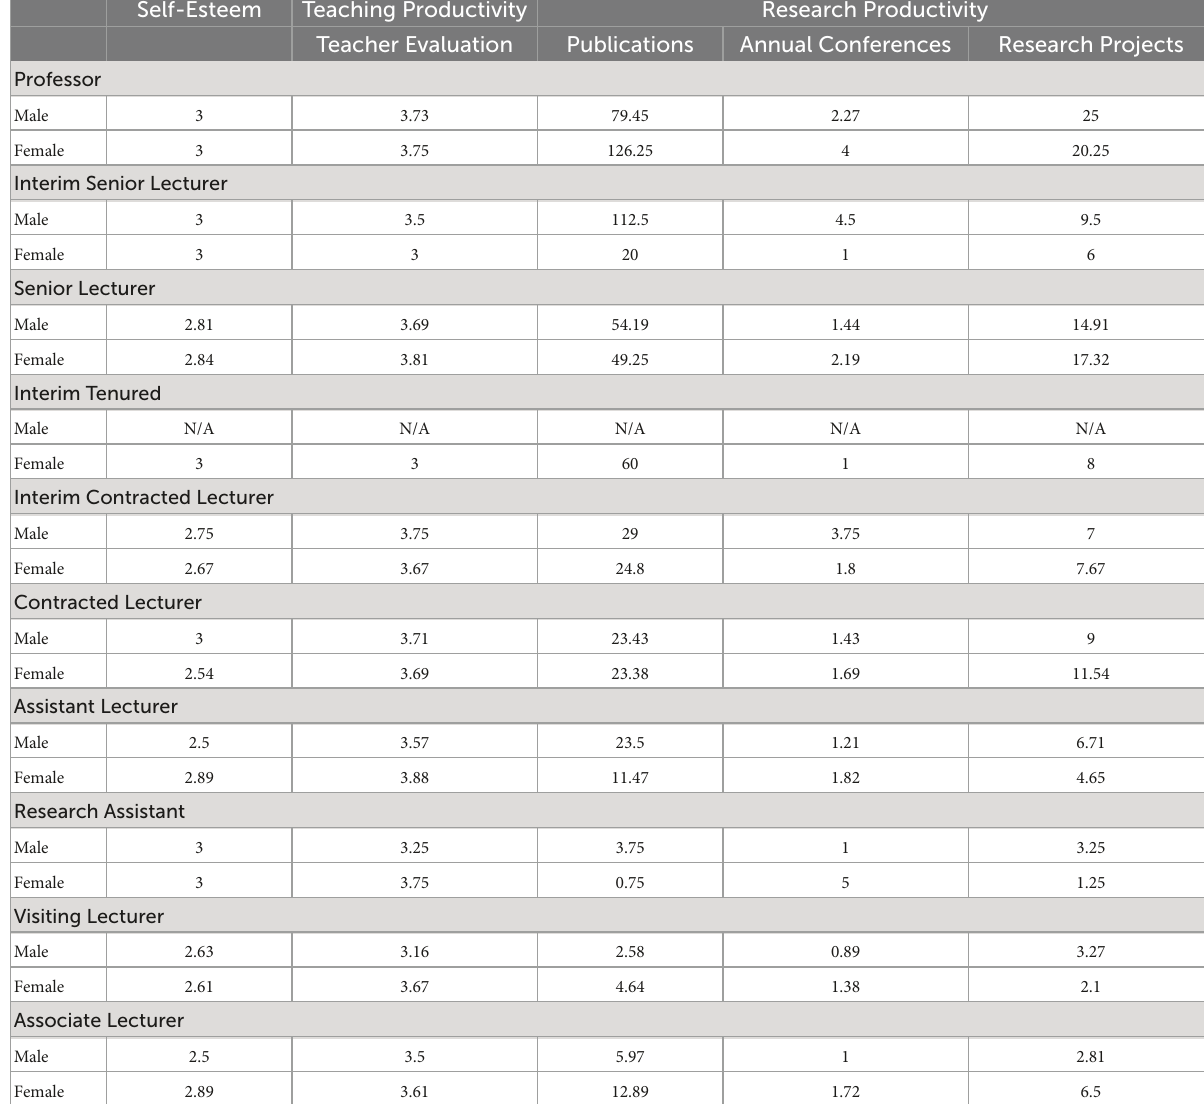
TABLE 4 Comparison with the difference of means of variable Productivity according to professional category and gender.